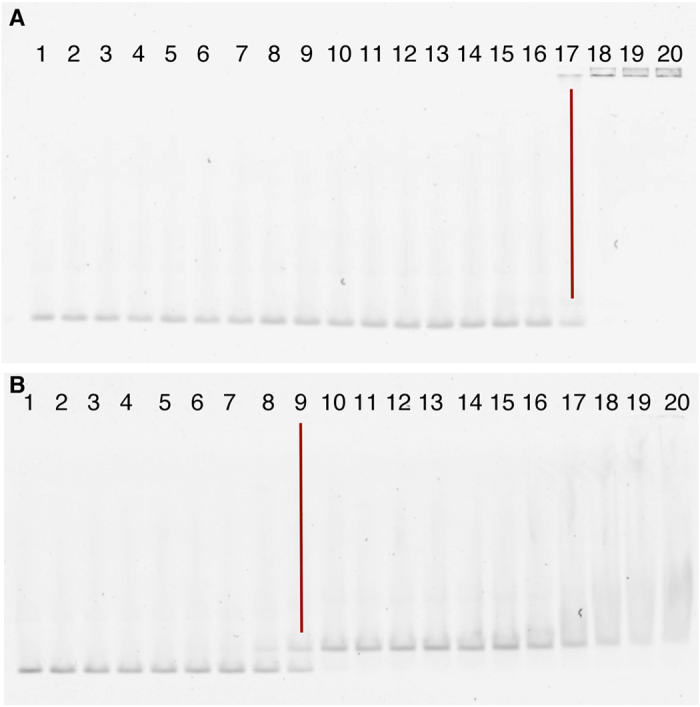
Gel retardation. (A) Gel retardation of CI-NTD on fluorescent DNA fragment P5 (containing OL) (0.4 nM). Kd lies around 1100 nM: lane 1, 0.016 nM; 2, 0.032 nM; 3, 0.065 nM; 4, 0.13 nM; 5, 0.26 nM; 6, 0.52 nM; 7, 1.0 nM; 8, 2.1 nM; 9, 4.1 nM; 10, 8.3 nM; 11, 17 nM; 12, 33 nM; 13, 66 nM; 14, 130 nM; 15, 270 nM; 16, 530 nM; 17, 1100 nM; 18, 2100 nM; 19, 4300 nM; 20, 8500 nM. (B) Gel retardation CI∆58 on fluorescent DNA fragment P5 (containing OL) (0.4 nM). Kd lies around 3 nM: lane 1, 0.011 nM; 2, 0.023 nM; 3, 0.045 nM; 4, 0.090 nM; 5, 0.18 nM; 6, 0.36 nM; 7, 0.72 nM; 8, 1.4 nM; 9, 2.9 nM; 10, 5.8 nM; 11, 12 nM; 12, 23 nM; 13, 46 nM; 14, 92 nM; 15, 180 nM; 16, 370 nM; 17, 740 nM; 18, 1500 nM; 19, 3000 nM; 20, 5900 nM. Red line indicates Kd.